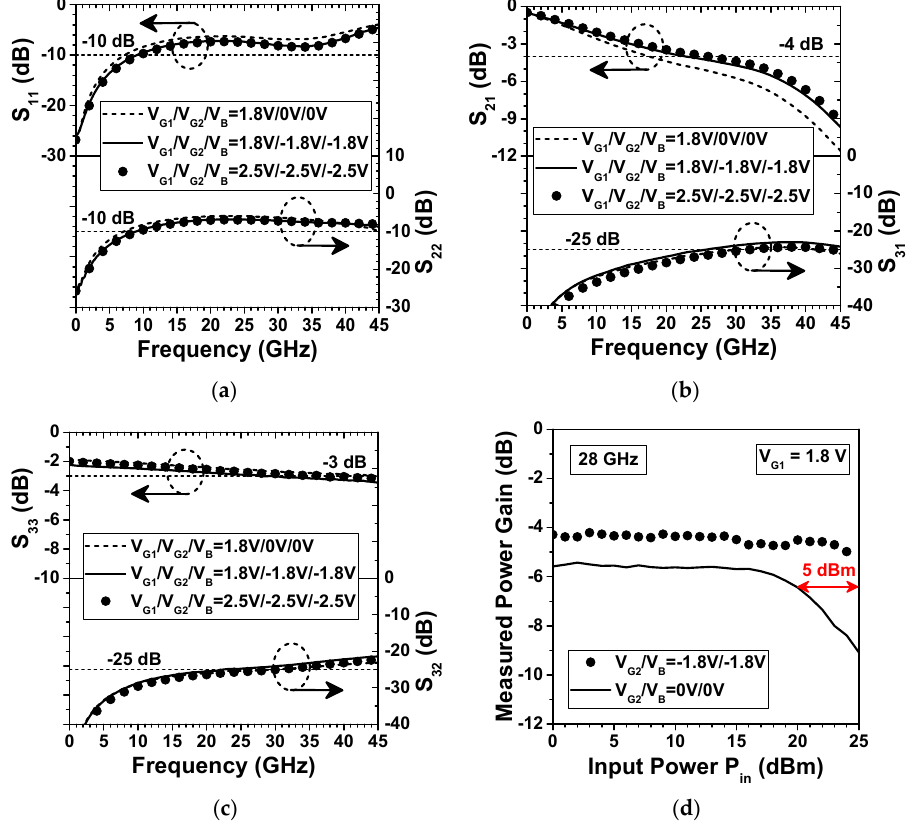
Figure 4. Measured ( a ) S 11 and S 22 ; ( b ) S 21 and S 31 ; ( c ) S 33 and S 32 , and ( d ) IP 1dB of the SPDT switch.